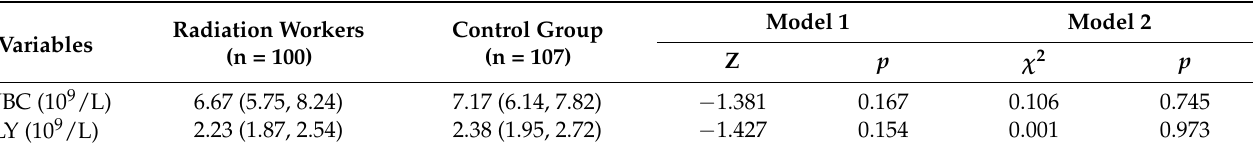
Table 2. Peripheral blood results